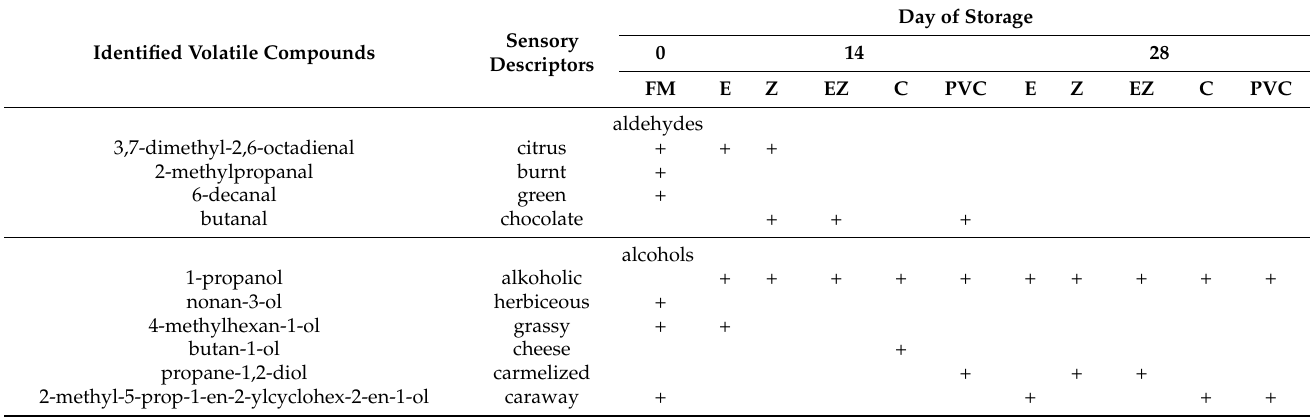
Figure 5. Analysis of principal components (PCA) of volatile compounds identified in mushrooms packed with active packaging containing zeolite (FZ), aҫai extract (FE), aҫai extract + zeolite (FEZ) in MAP, without active packaging in MAP (C) and wrapped in polyvinyl chloride foil (PVC) and analyzed in fresh mushrooms (FM, day 0), after 14 ( A ) and 28 ( B ) days of storage. Table 3. Volatile compounds identified in mushrooms packed with active packaging containing zeolite (FZ), aҫai extract (FE), a ҫ ai extract + zeolite (FEZ) in MAP, without active packaging in MAP (C), wrapped in polivynyl chloride foil (PVC) and fresh mushrooms (FM) after 0, 14 and 28 days of storage).